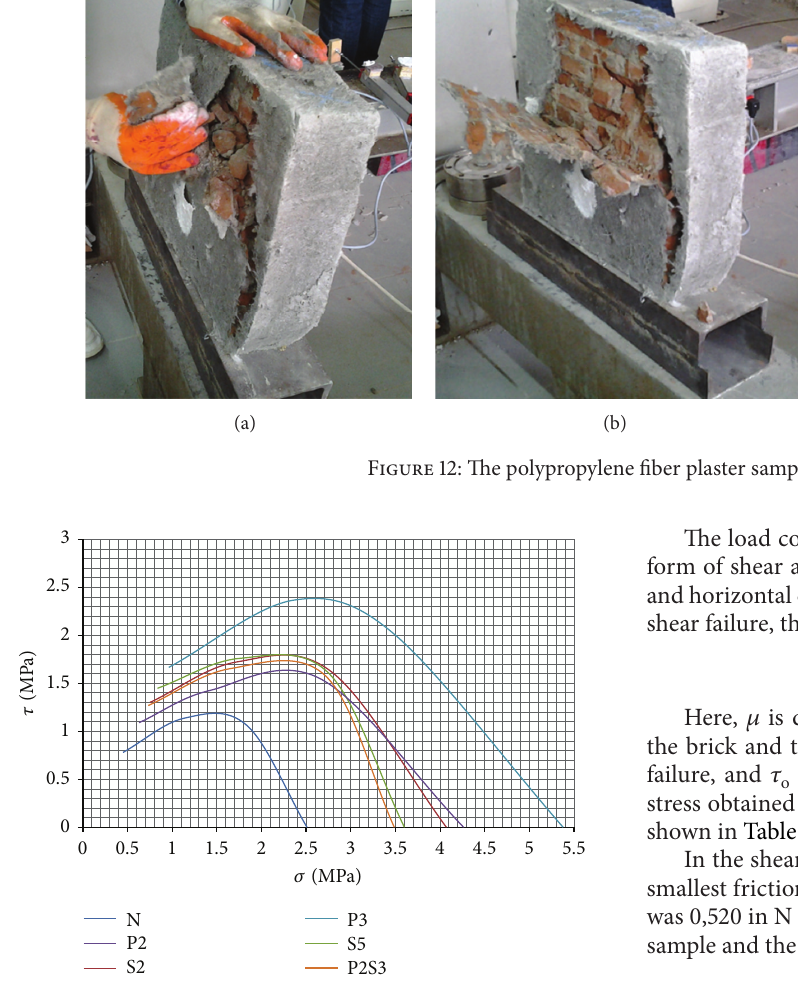
Figure 13: 𝜎 and 𝜏 values obtained from the maximum